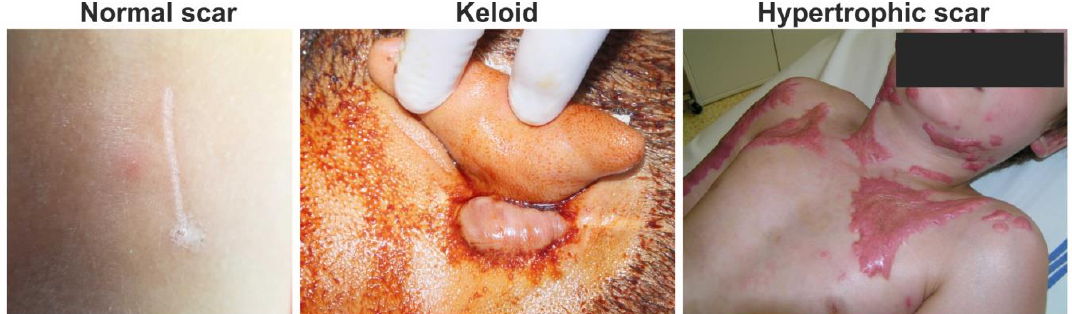
Figure 1. Clinical photos of normal, keloid and hypertrophic scars: normal fine line scar following a surgical wound ( left ); keloid scar, which extends beyond the original wound ( middle ); and hypertrophic scar, which does not extend beyond the initial site of the skin lesion associated with burn injury ( right ).